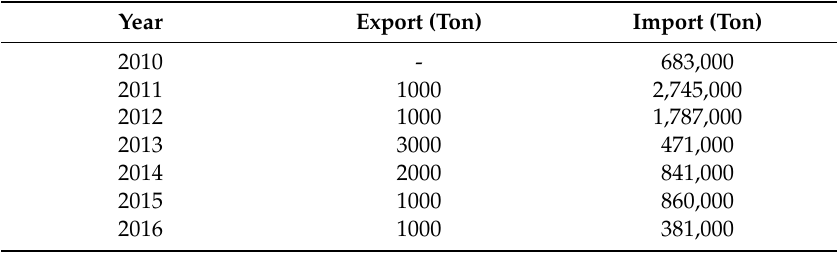
Table 2. Volume of rice export and import in